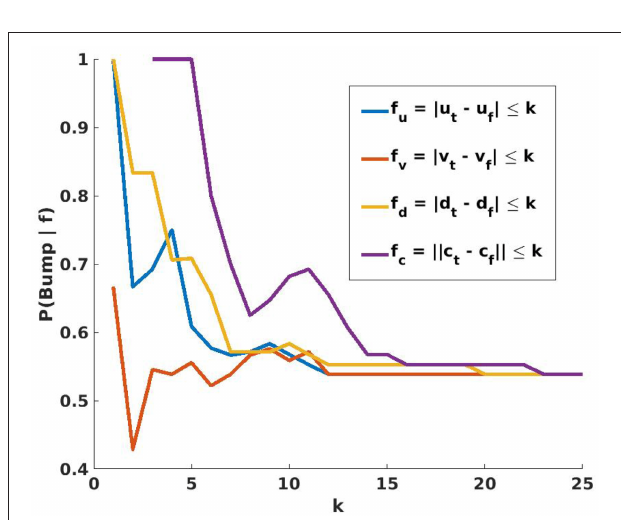
FIGURE 5 | Given percepts for hand and target object, the agent searches for the feature f that will maximize the conditional probability P ( Bump | f ). Each feature considers the centers of the palm and target in ( u , v , d ) image-space. f u , f v , and f d evaluate to true if the absolute difference in one coordinate is less than a variable threshold k , and f c is true if the distance between centers is less than k . The probabilities shown in this graph are based on the 102 trajectories used previously, and their outcomes. For all values of k , P ( Bump | f ) is maximized when f = f c . The agent therefore selects as n f the candidate node where the hand is closest to the target object, thereby minimizing k and maximizing P ( Bump | f